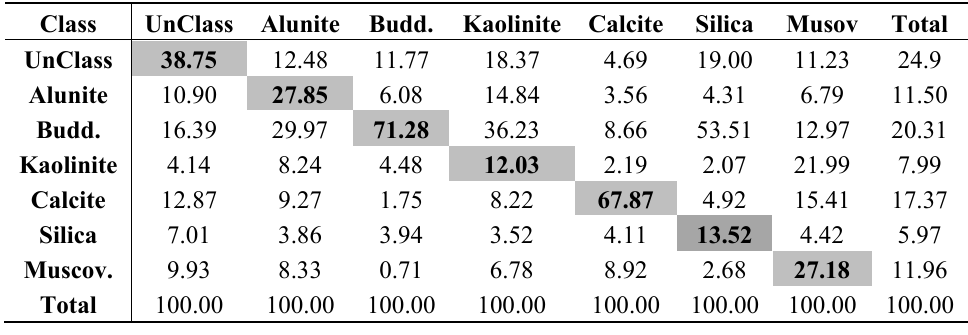
Table 4. ( a ) Confusion matrix comparing ASTER mineral mapping to AVIRIS mineral mapping. Overall accuracy is 35.05%, Kappa Coefficient is 0.2074 (Poor, Table 3); ( b ) Confusion matrix comparing simulated WV-3 mineral mapping to AVIRIS. Overall accuracy is 50.92%, Kappa Coefficient is 0.3843 (Poor); ( c ) Confusion matrix comparing ASTER mineral mapping to AVIRIS mineral mapping, excluding unclassified pixels. Overall accuracy is 35.99%, Kappa Coefficient is 0.2397 (Poor); ( d ) Confusion matrix comparing simulated WV-3 mineral mapping to AVIRIS, excluding unclassified